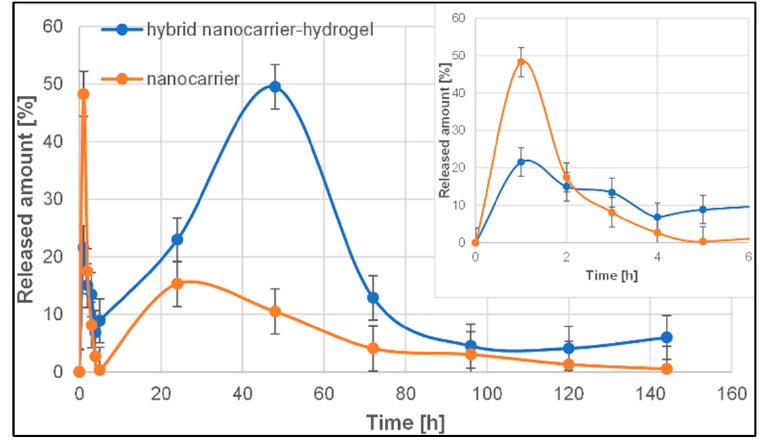
Figure 12. Comparison between the release profile of salicylic acid from thermosensitive nanocarrier (orange line, T-SA) and bio-hybrid hydrogel matrix (blue line, M-T-SA), at pH = 7.4 and T = 37 °C.